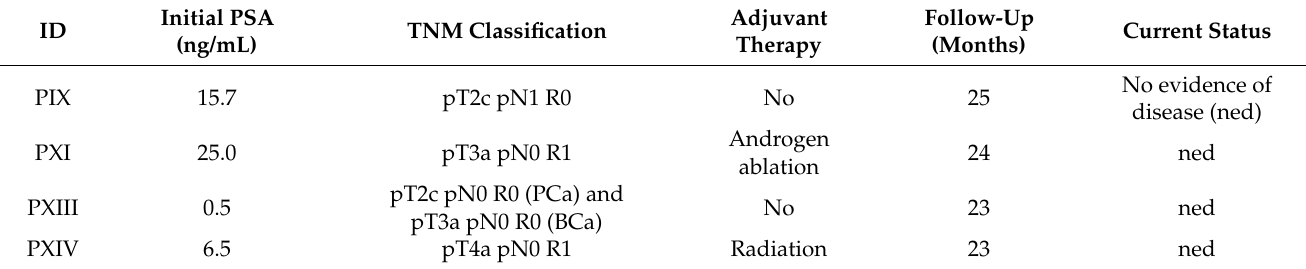
Table 2. Donors’ clinical characterizations and therapy